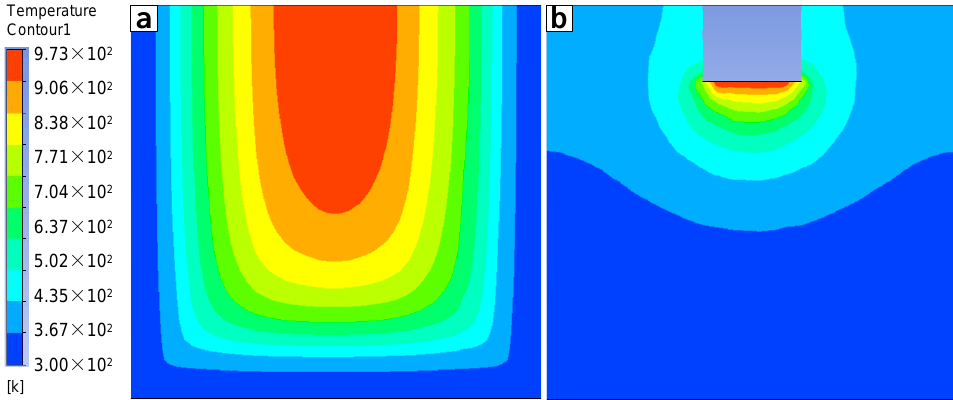
Figure 11. Comparison of temperature distribution between ( a ) no ultrasonication and ( b ) ultrasonication.